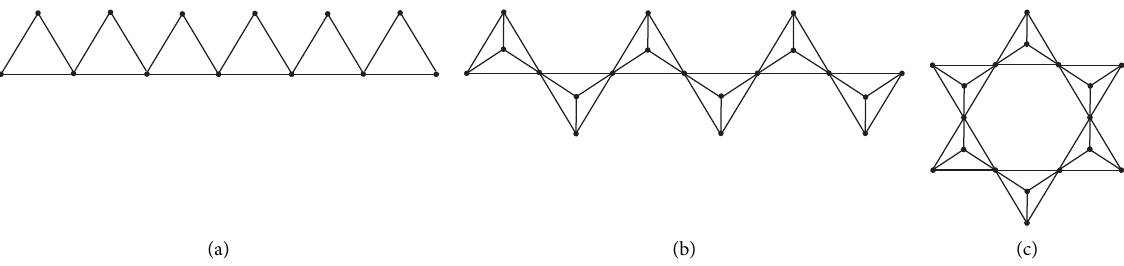
Figure 2: Path-of-complete graphs. (a) PC ( 7 ; 3 ( 6 − times )) . (b) PC ( 7 ; 4 ( 6 − times )) . (c) Cycle-of-complete graph CC ( 6 ; 4 ( 6 − times ))